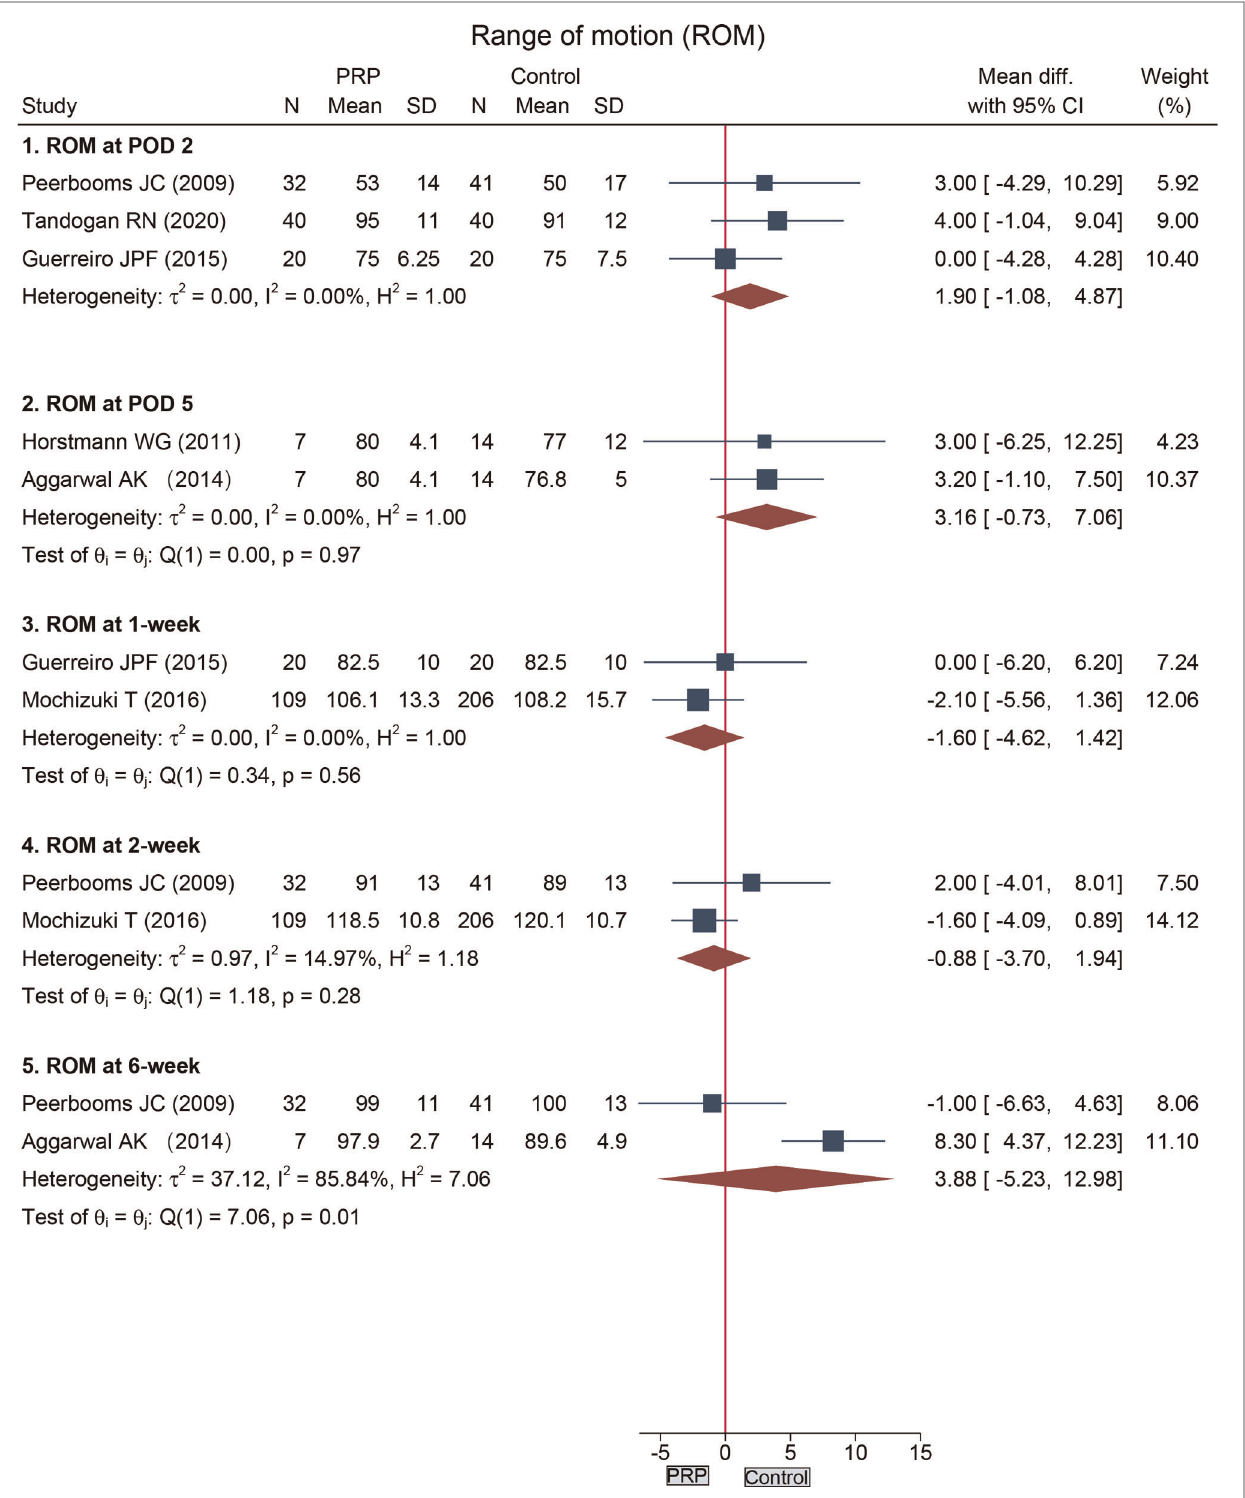
Frontiers in Surgery |